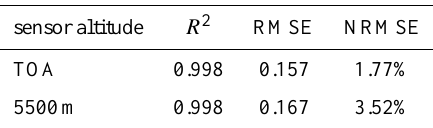
Table 3. Quantitative comparison between SMART and 6S by statistical means for the limited conditions as defined in Table 1. SMART uses the HG phase function; 6S used the phase function from Mie calculations. R 2 denotes the squared correlation coef- ficient, RMSE the root mean square error and NRMSE the nor- malised RMSE. sensor altitude R 2 RMSE NRMSE TOA 0.998 0.157 1.77% 5500m 0.998 0.167